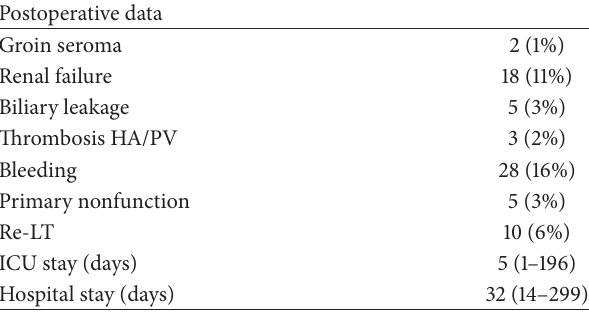
Table 4: Postoperative hospital stay and